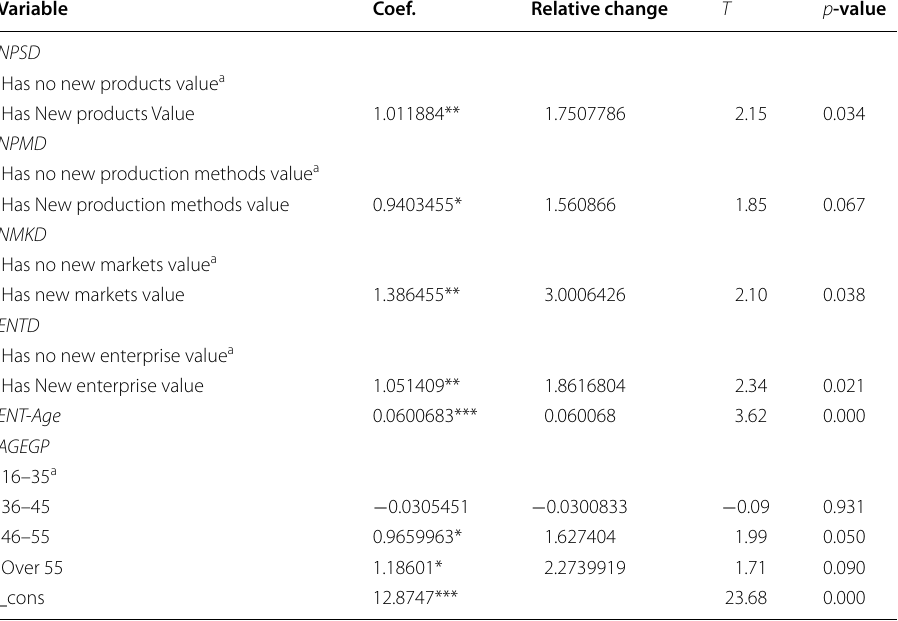
Table 4 Results of regression analyses on relative contribution of innovations towards aggregate entrepreneurship value